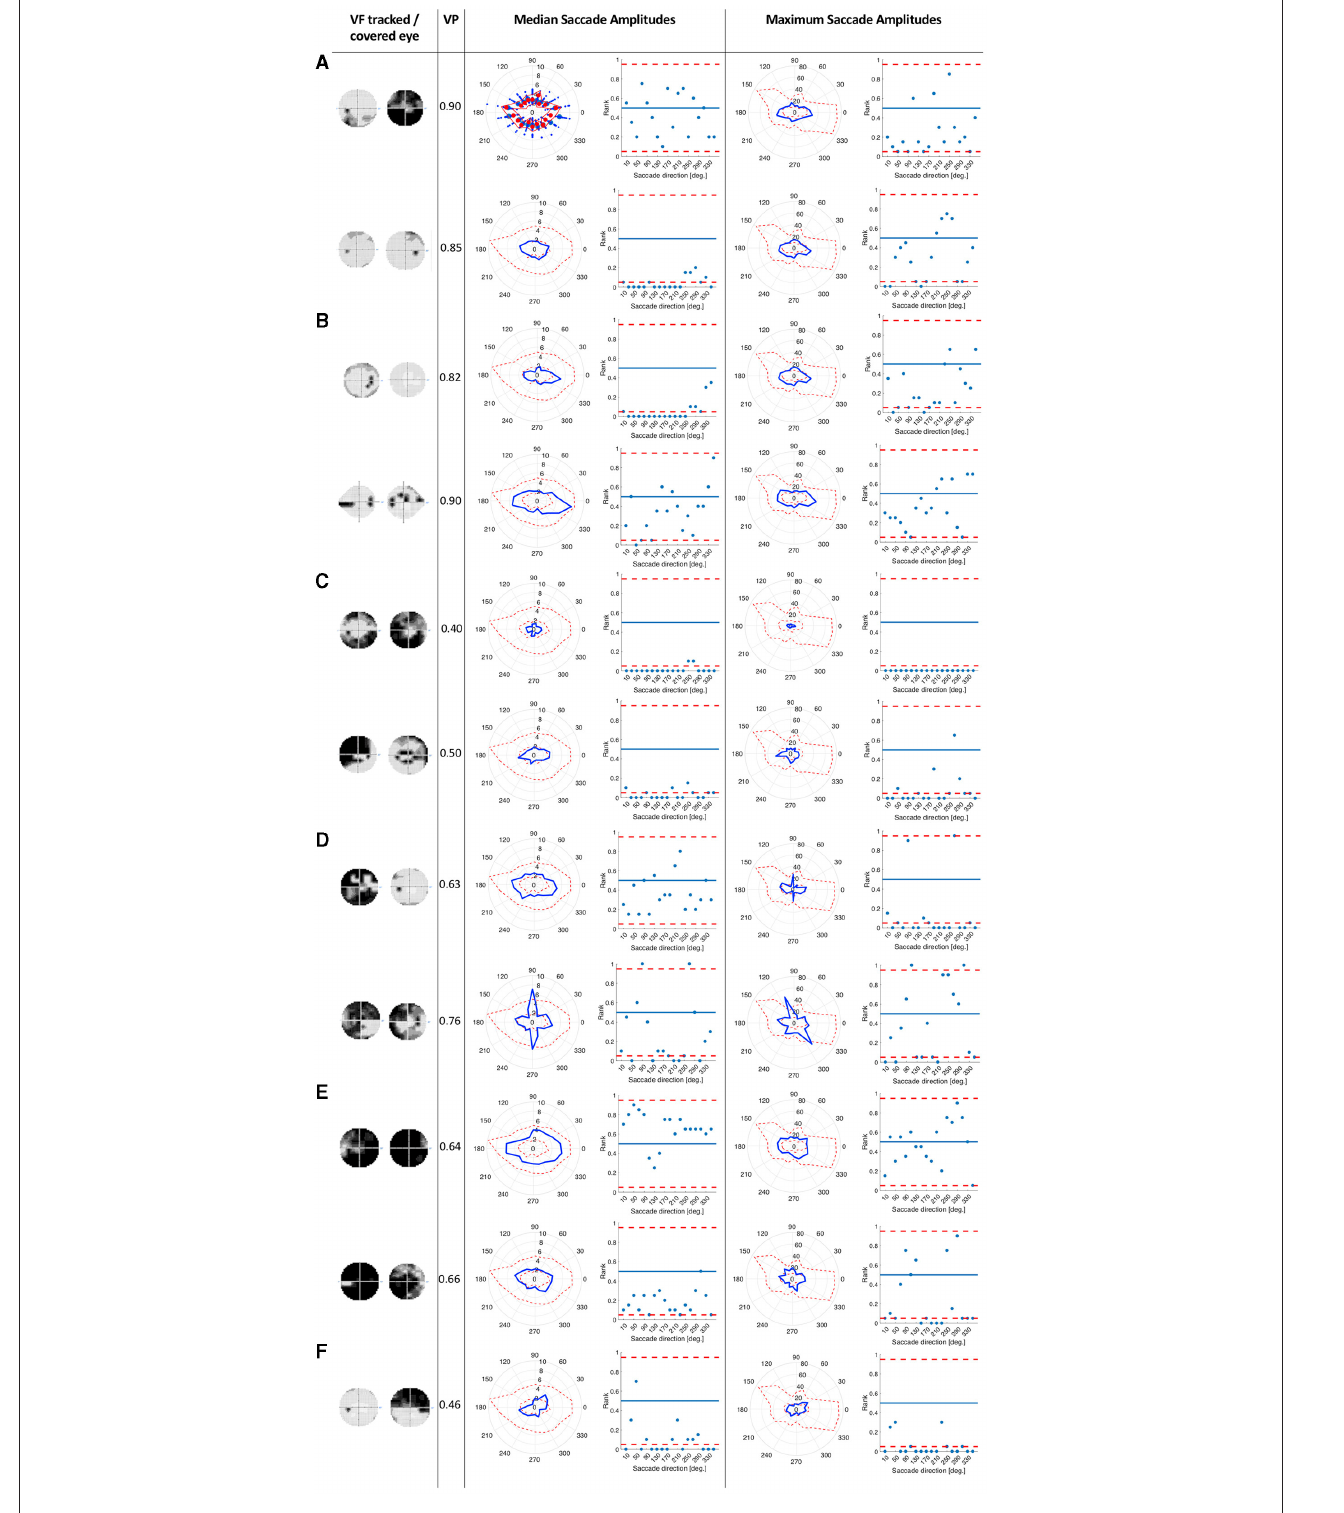
FIGURE 2 | This figure consists of a series of panels, each for a group of patients with different VF characteristics. In each panel, the first column shows the visual fields of the patient as measured by SAP, with darker areas representing the less sensitive areas of the visual field. The first one is the visual field of the eye used during the experiment and the second one is the covered eye. The second column lists the average VP of the patient. The left figure in the third column shows the median